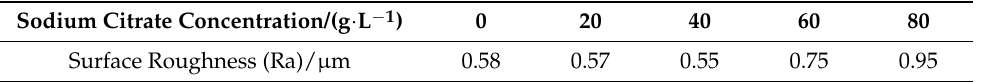
Table 3. Effect of sodium citrate concentration on the surface roughness of